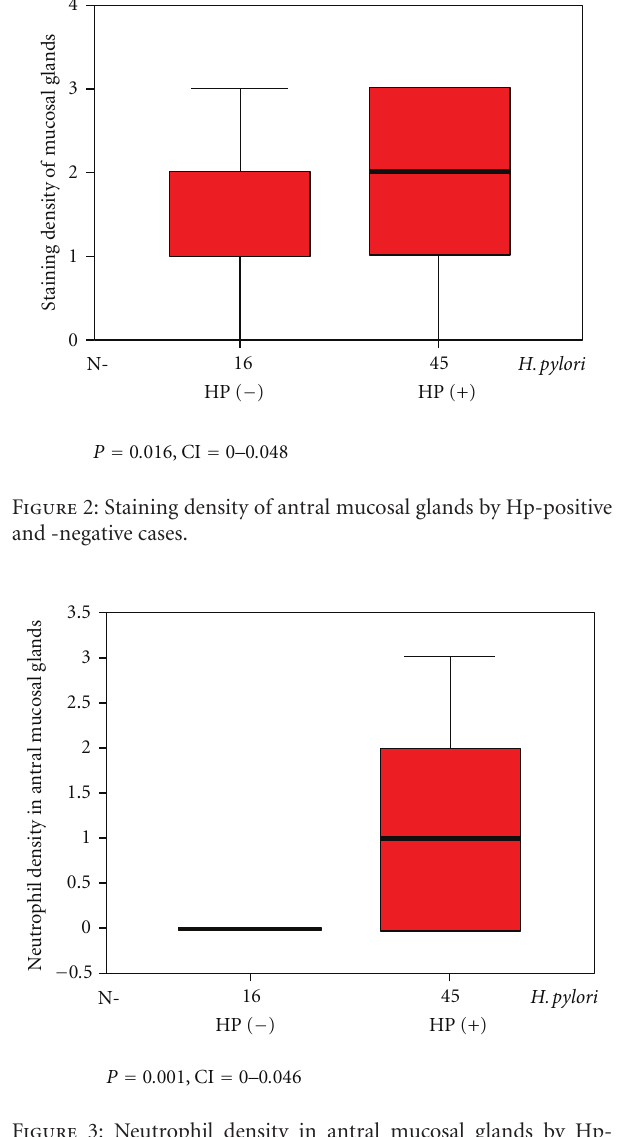
Figure 3: Neutrophil density in antral mucosal glands by Hp- positive and -negative